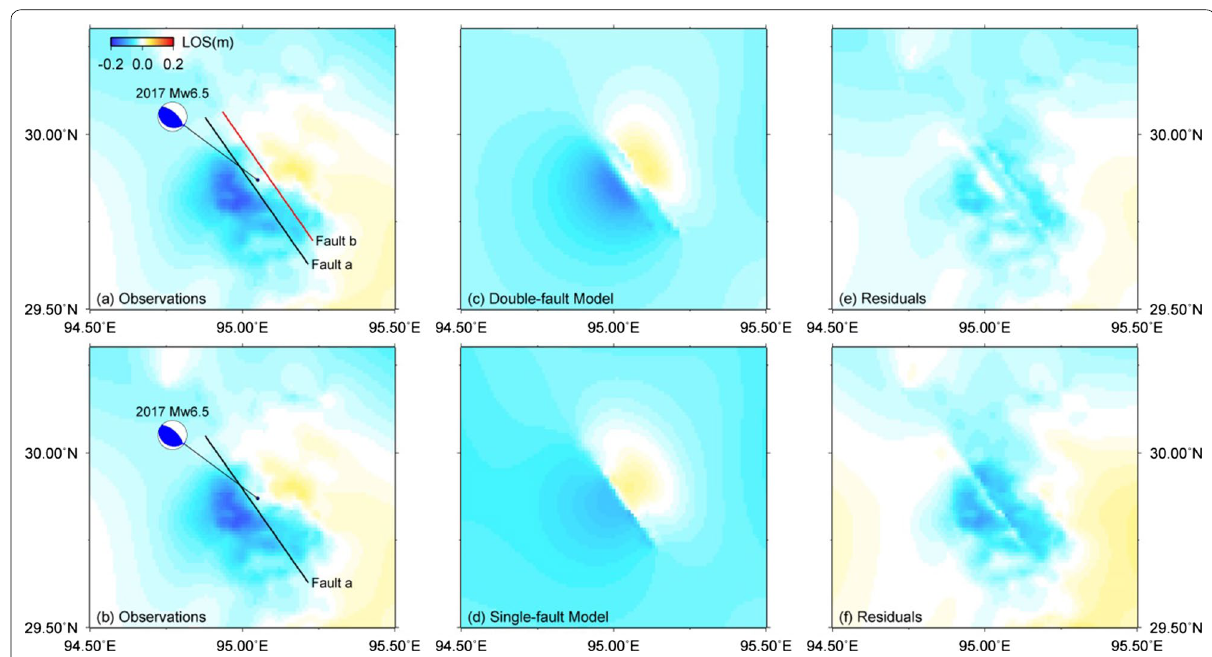
Fig. 5 a , b Observations of ascending orbit. c , d Modeled displacements from the double-fault model and single-fault model. e , f Residuals